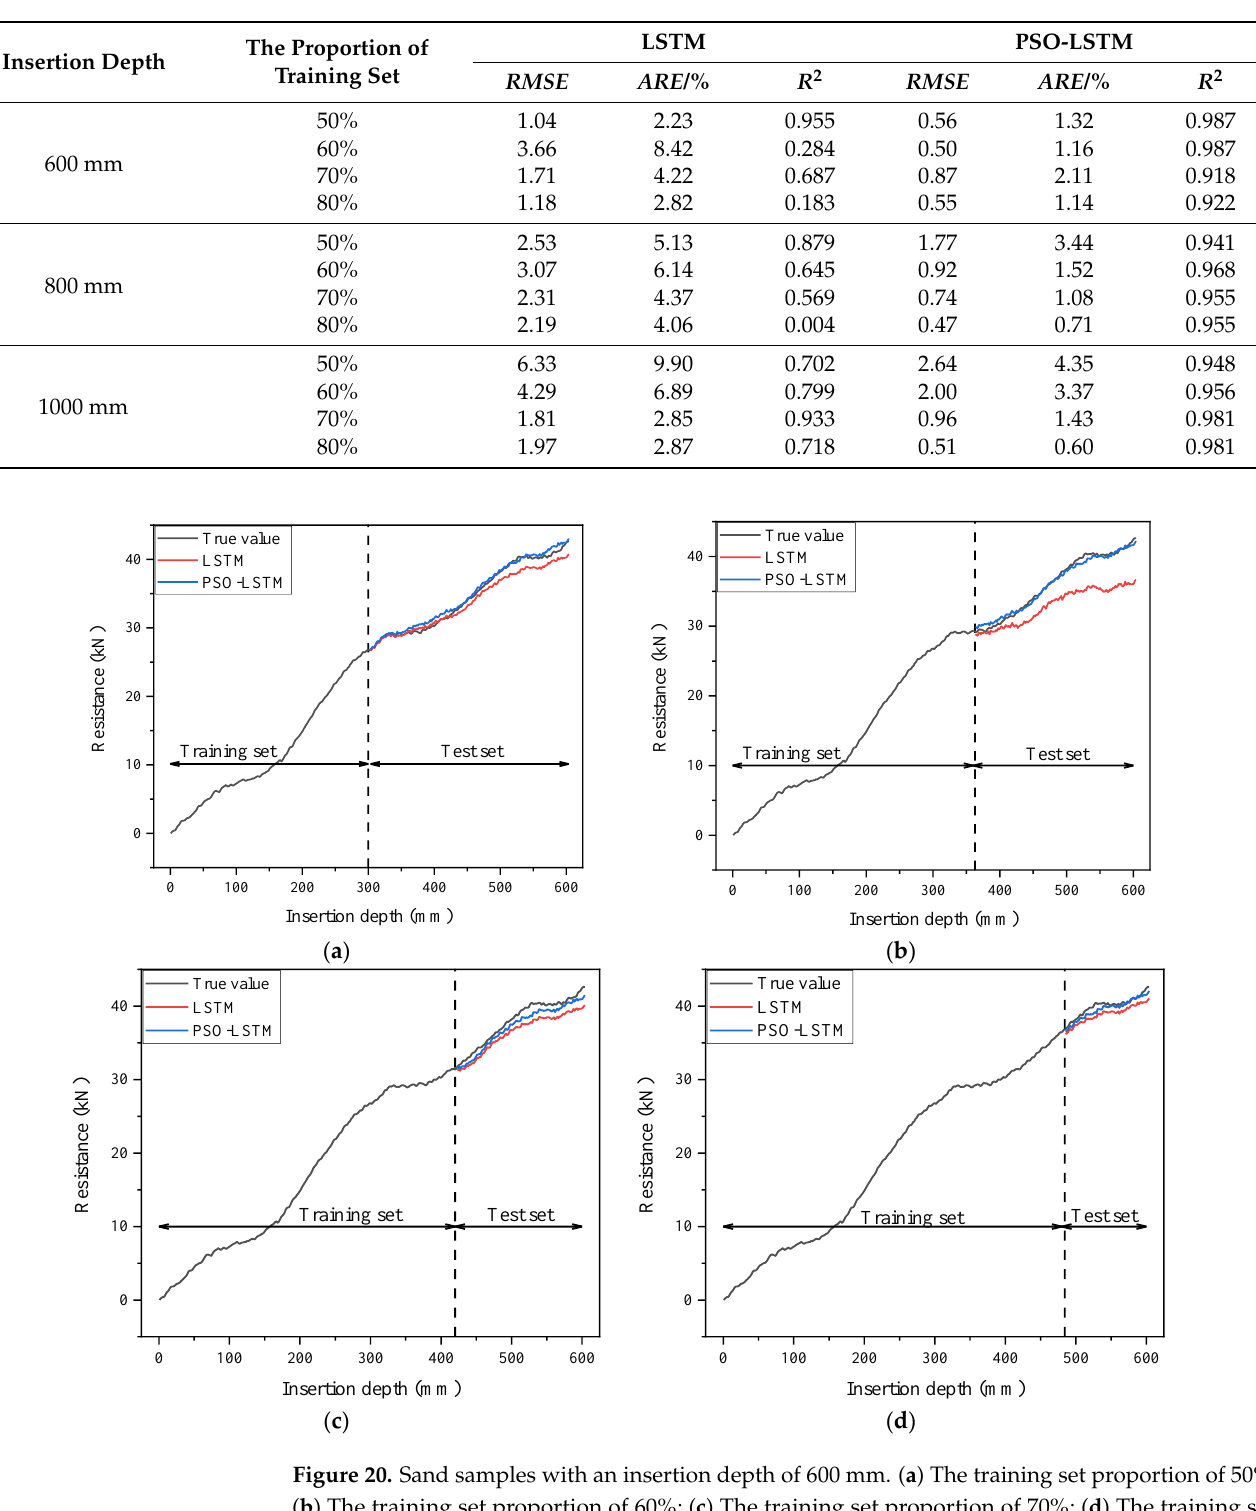
Table 7. PSO-LSTM optimization parameters for the gravel sample groups. Table 8. LSTM and PSO-LSTM prediction performance for the sand sample groups.